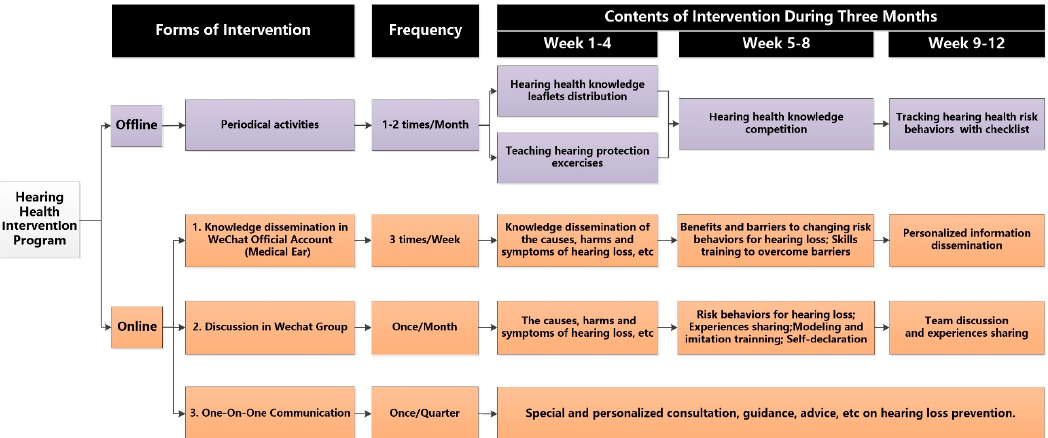
Figure A1. The health intervention program for hearing loss-related behaviors based on the health belief model among college students.